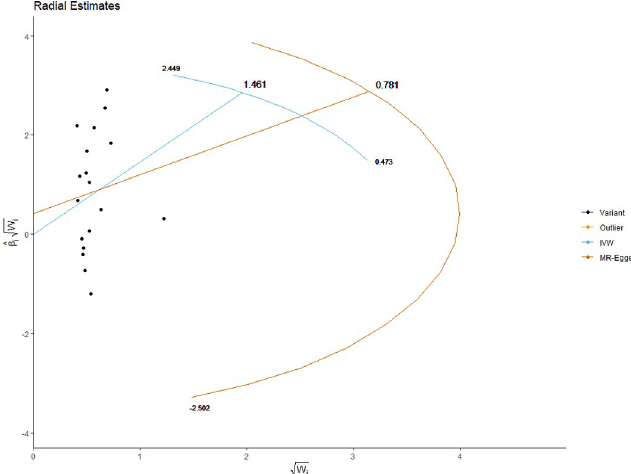
Fig 19. Radial plot of waist circumference as the exposure. No significant outliers were